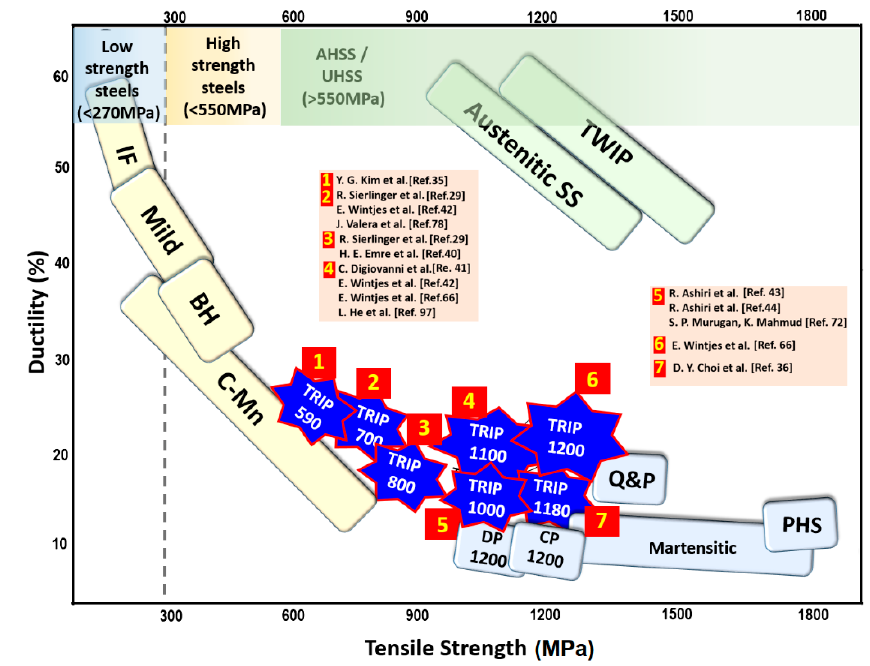
Figure 3. LME studies of several transformation-induced plasticity (TRIP) sheets of steel. IF = Interstitial free, BH = Bake hardening, Q&P = Quenching and partitioning, PHS = Press hardenable steel. Adapted from [33], with permission from Taylor and Francis, 2018, http://www.tandfonline.com/. Table 1. Studies for LME of resistance spot-welded TRIP